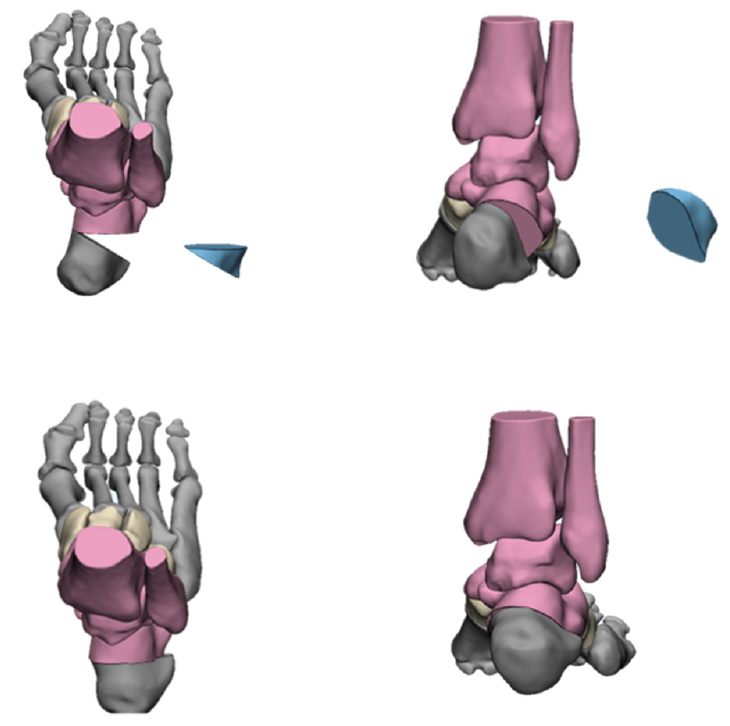
Figure 15. The Dywer calcaneus Osteotomy.